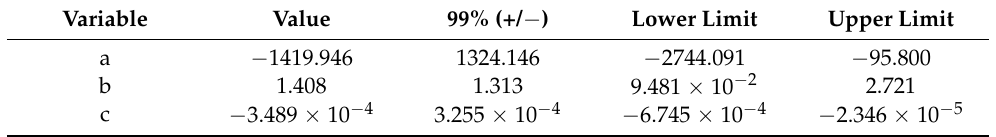
Table 10. Values of the coefficients of the mathematical model for a 99% confidence interval of the function.